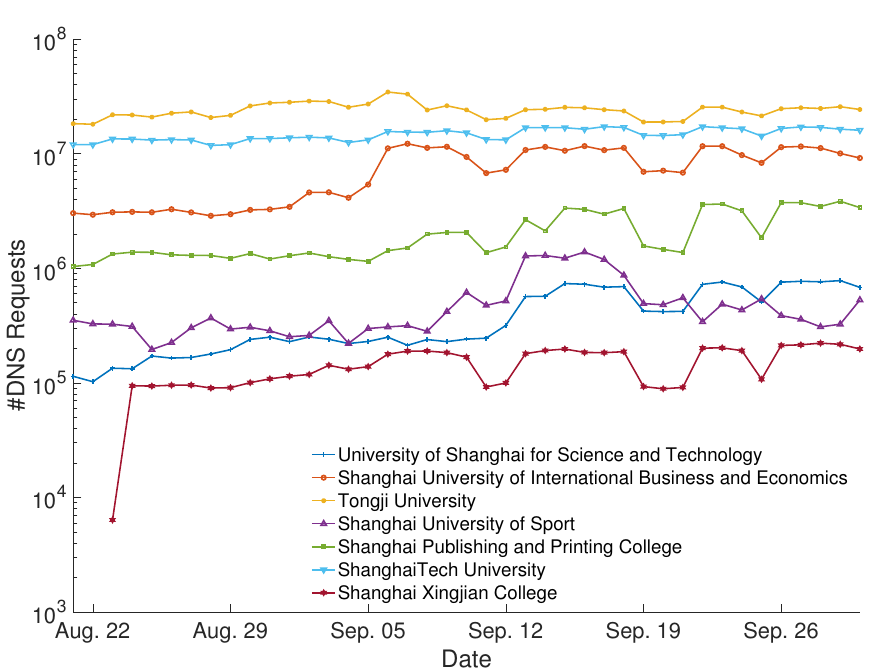
Figure 2. Number of DNS requests from August 21 to September 30 at seven universities. Figure 3 shows that the trends of daily IPv4 and IPv6 DNS requests were generally consistent across universities. However, for each university, there was an order of magni- tude difference in the number of daily DNS requests between IPv4 and IPv6. The results indicated that IPv4 traffic still dominated in the CERNET environment at the time.